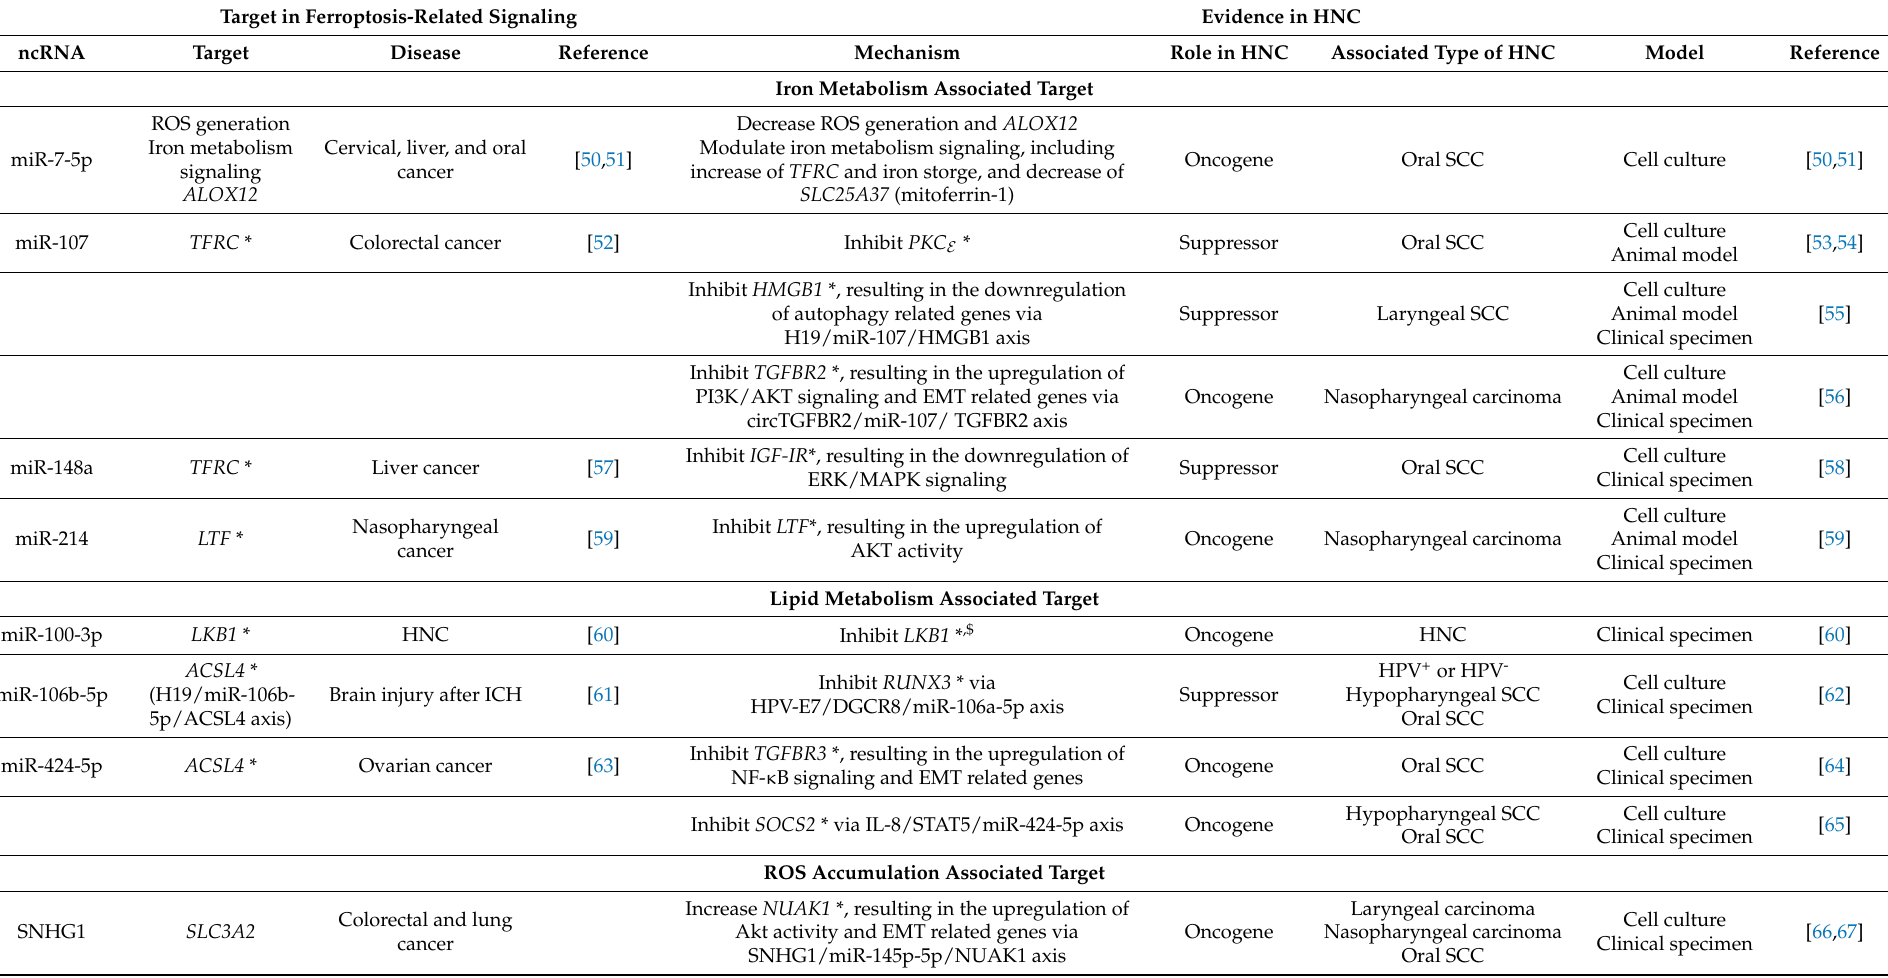
Table 1. Ferroptosis associated-ncRNAs in head and neck